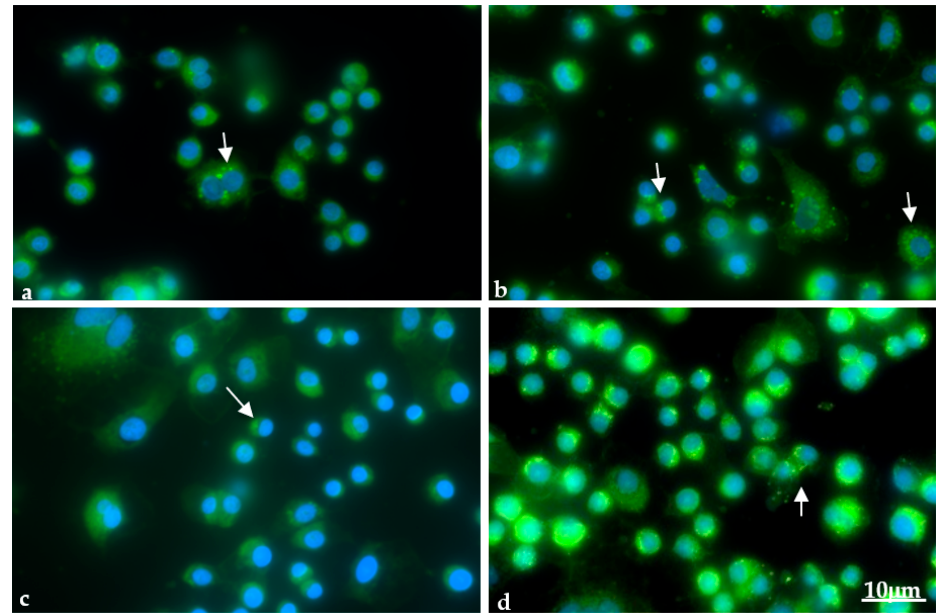
Figure 4. Immunofluorescence micrographs shown the morphological alterations on SKBR3 cells induced by Vepris macrophylla EO after treatment with 1.25 ( a , c ) and 2.5 µ g/mL ( b , d ) concentrations at two incubation times 24 h ( a , b ) and 48 h ( c , d ). Arrowheads indicate probably vesicles filled with EO.